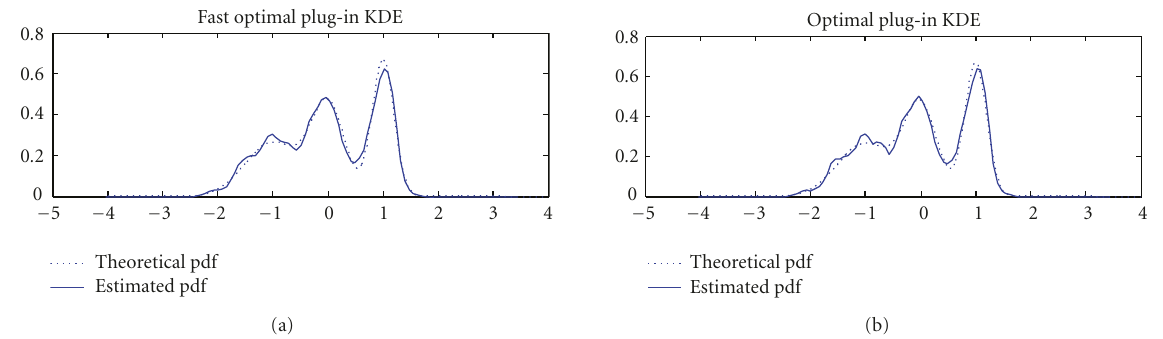
Figure 2: Estimation of simulated pdf using optimal plug-in KDE and fast optimal plug-in KDE (power 4.5).